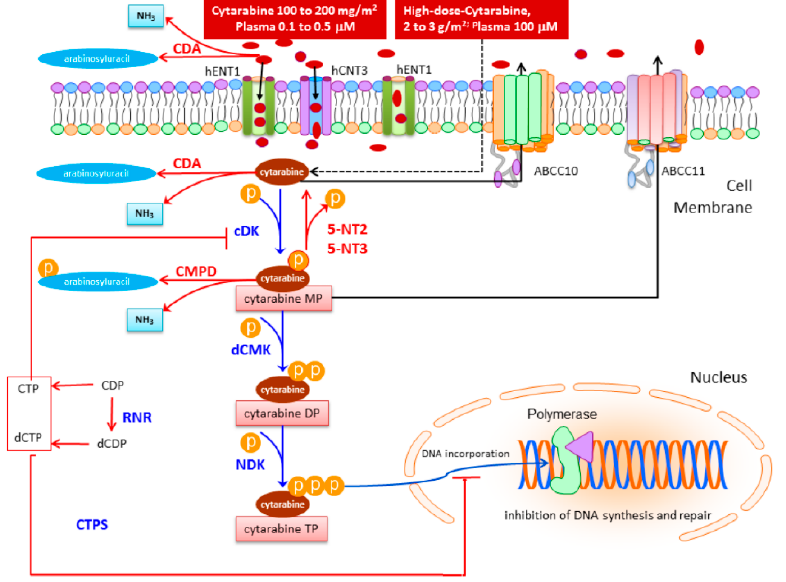
Figure 1. As with other nucleoside analogues and their physiologic counterparts, cytarabine enters cells via nucleoside transport proteins, the most important one being the equilibrative inhibitor- sensitive (es) receptor (ABC). Once inside the cell, cytarabine requires activation for its cytotoxic effects. The first metabolic step is the conversion of cytarabine to cytarabine monophosphate by the enzyme deoxycytidine kinase (DCK). Cytarabine is subsequently phosphorylated to cytarabine diphosphate and cytarabine triphosphate, respectively. Cytarabine triphosphate is a potent inhibitor of DNA polymerases, which, in turn, interferes with DNA chain elongation, DNA synthesis, and DNA repair. In addition, cytarabine is incorporated directly into DNA and functions as a DNA chain terminator, interfering with chain elongation. Catabolism of cytarabine involves two key enzymes, cytidine deaminase (CDA) and deoxycytidyne monophosphate deaminase (DCMD). These breakdown enzymes convert cytarabine and cytarabine monophosphate into the inactive metabolites, uracil arabinoside and arabinosyluracil monophosphate, respectively. Other catabolic enzymes that may affect cytarabine metabolism include pyrophosphatase, 5-nucleotidase. The balance between intracellular activation and degradation is critical in determining the amount of drug that is ultimately converted to cytarabine triphosphate and, thus, its subsequent cytotoxic and antitumor activity.